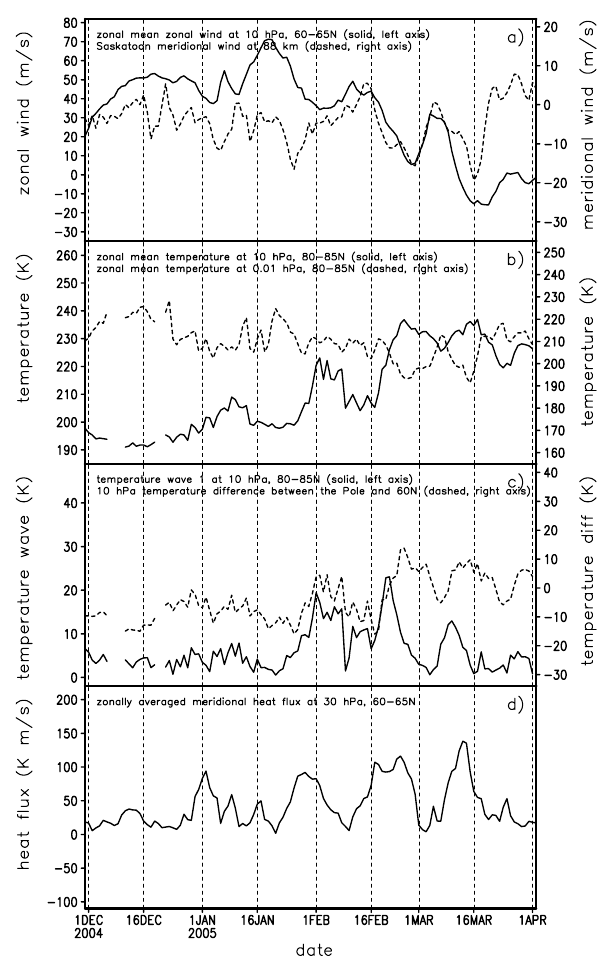
Fig. 1. The day-to-day variability of UKMO zonal mean zonal wind at 10hPa, 60–65 ◦ N and meridional wind at 88km over Saskatoon (52 ◦ N, 253 ◦ E) (panel a ); MLS zonal mean temperatures at 10hPa and 0.01hPa, 80–85 ◦ N (panel b ); Amplitude of MLS temperature planetary wave number 1 and zonal mean temperature difference between the North Pole (80–85 ◦ N) and 60–65 ◦ N for the 10hPa level (panel c ); and UKMO zonally averaged meridional heat flux at 30hPa, 60–65 ◦ N (panel d ), during the 2004/2005